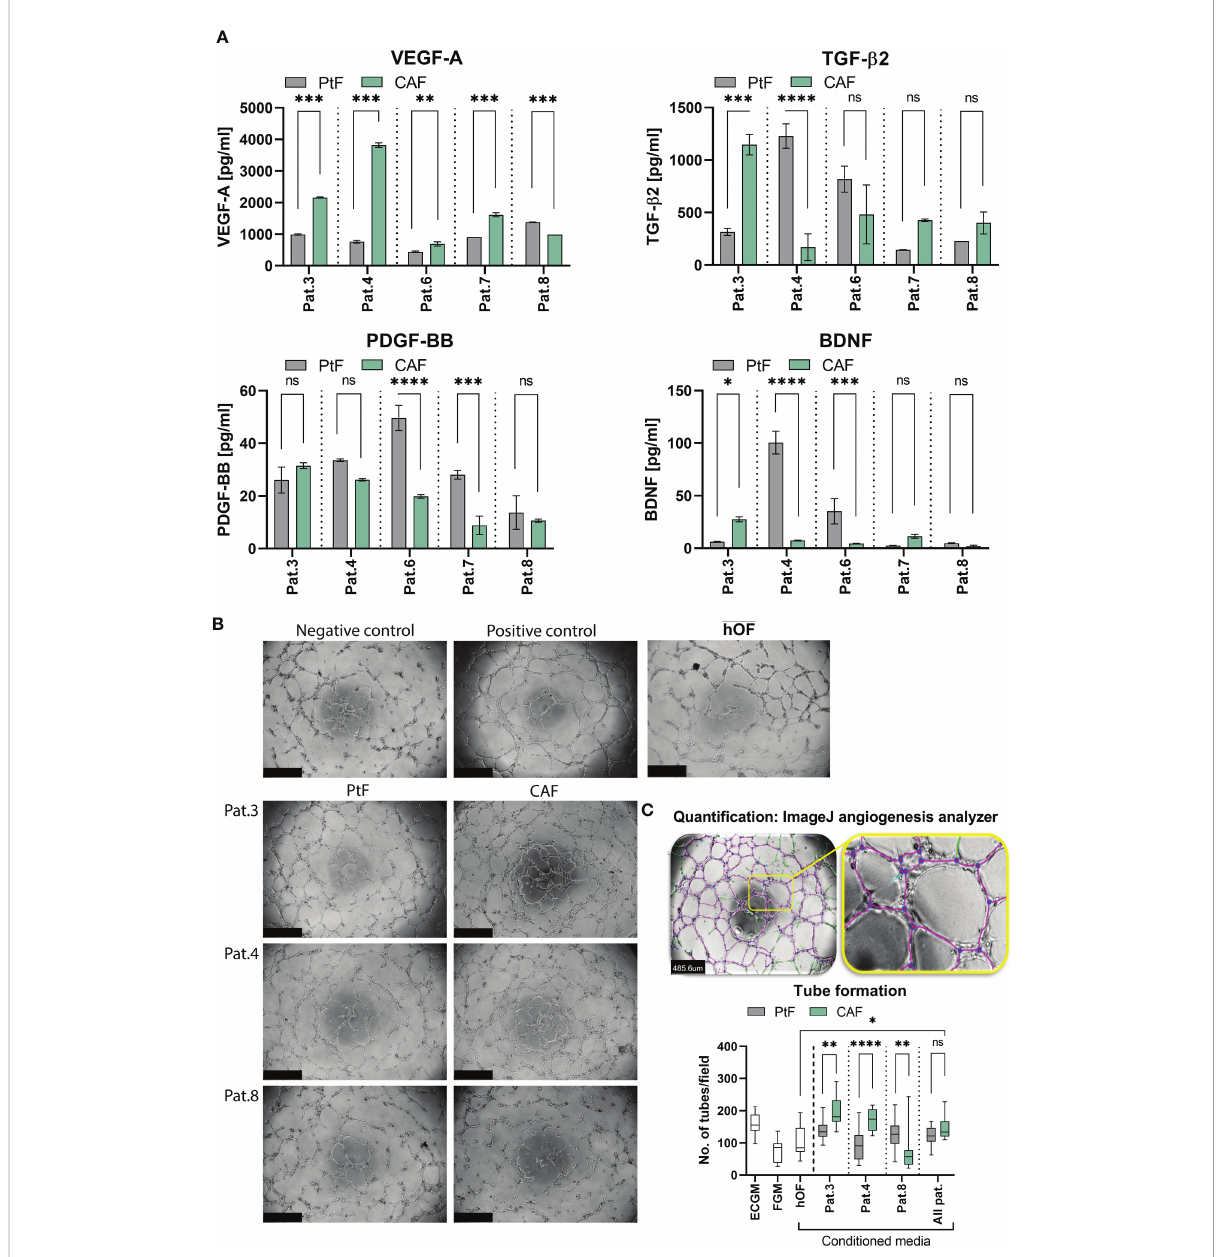
FIGURE 5 Growth factor secretion and effect of PtFs and CAFs on the angiogenic potential of HUVECs. (A) Secretion of VEGF-A, TGF- b 2, PDGF-BB and BDNF of PtFs and CAFs was measured by ELISA in all patients (Pat.3, Pat.4, Pat.6, Pat.7 and Pat.8). Shown are mean ± SD values of each analyte from n=3 individual experiments. (B) Representative images showing angiogenic potential of HUVECs in ECGM (positive control, top right), and in FGM (negative control, top left). The lower panel shows representative images of tube formation in HUVECs when cultured in PtF/CAF- conditioned medium of Pat3, Pat.4 and Pat.8. Uper right picture shows HUVECs cultured in the presence of hOF supernatant. Images were captured after 8 hour treatment. (C) Analysis of tube formation ability in HUVECs (top panel) with purple lines depicting tubes between two connected junctions (blue dots) and green lines depicting unconnected segments. Number of connected tubes of HUVEC cultured in negative and positive controls, and with hOF/PtF/CAF-conditioned supernatants of individual patients are determined (bottom panel). Shown are mean ± SD values. P-values: ns > 0.05; * ≤ 0.05; ** ≤ 0.01; *** ≤ 0.001; **** ≤